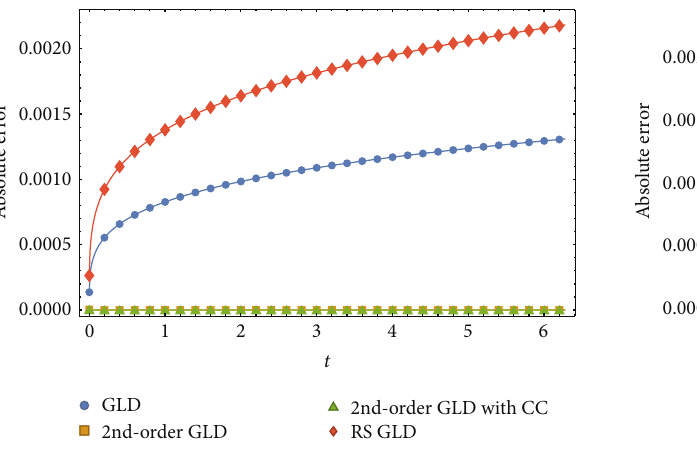
Figure3:Absoluteerrorforincreasing 𝑁 forfourdifferentmethods.